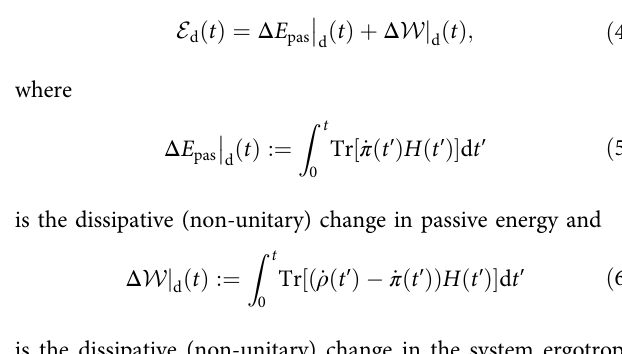
unraveling of the fi rst law of thermodynamics for quantum systems that constitutes one of our main results.